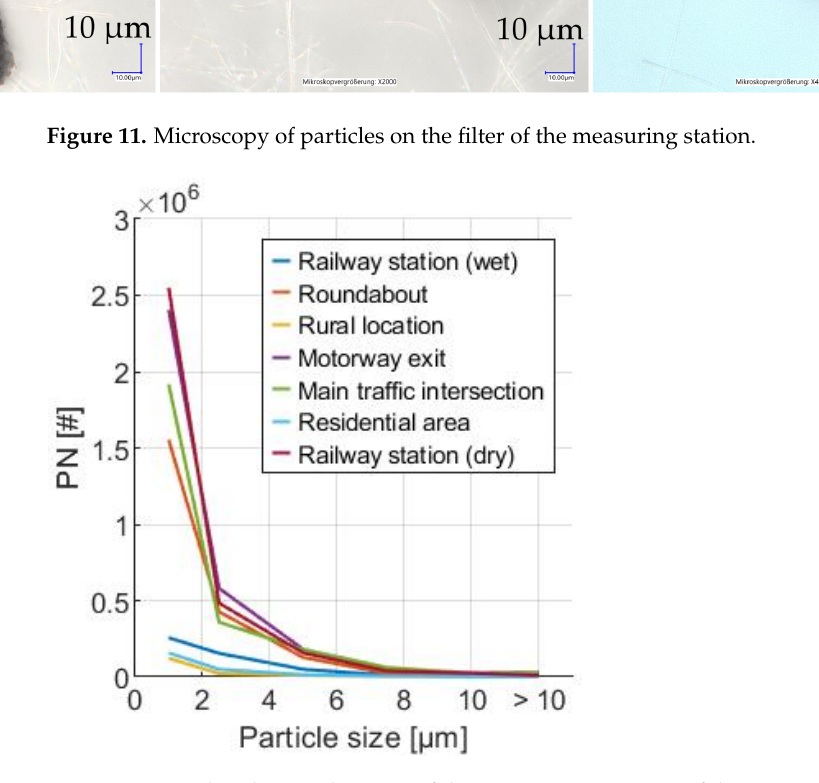
Figure 12. Size distribution densities of the measuring positions of the measuring